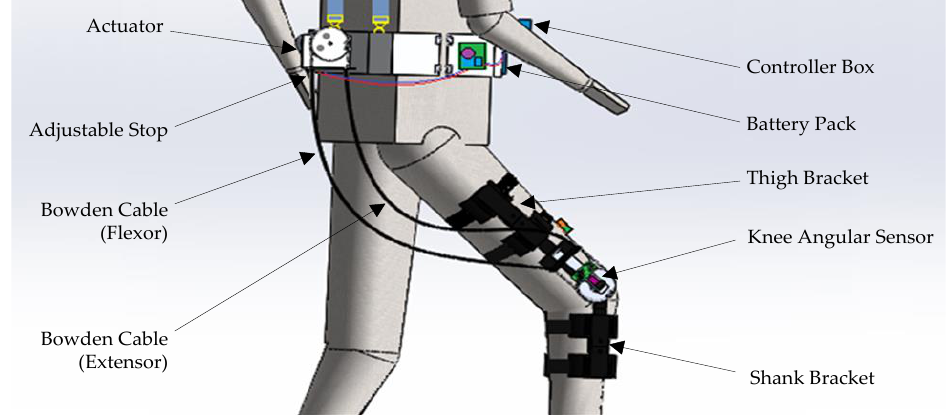
Figure 1. Overall design of the soft knee exoskeleton with the Bowden cable transmission system worn by the user.